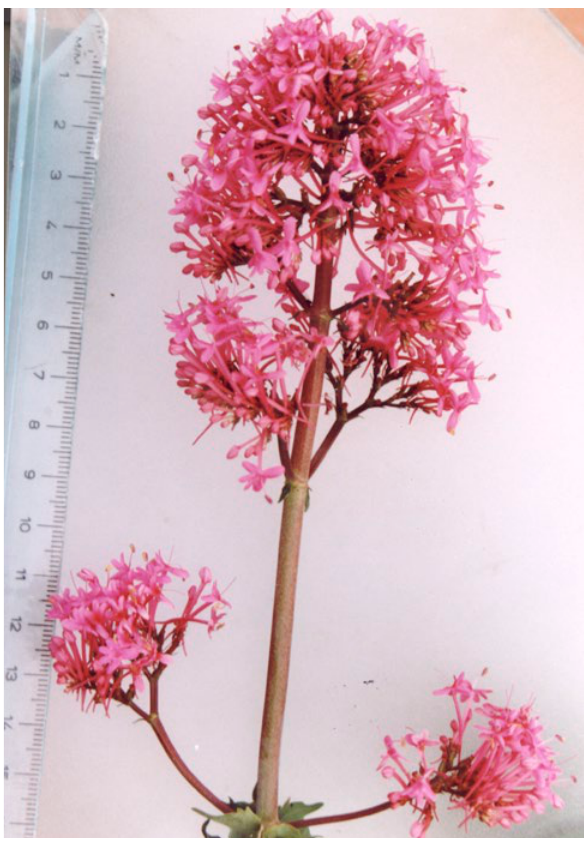
Figure 2. Size reduction of Centranthus ruber flower af - fected by CMV (left) compared to a flower from a healthy plant